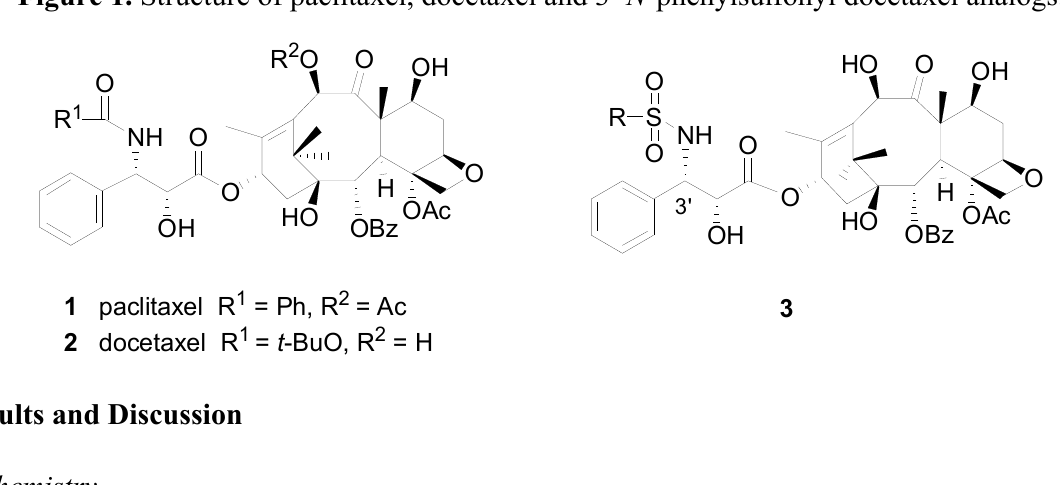
Figure 1. Structure of paclitaxel, docetaxel and 3 ′ - N -phenylsulfonyl docetaxel